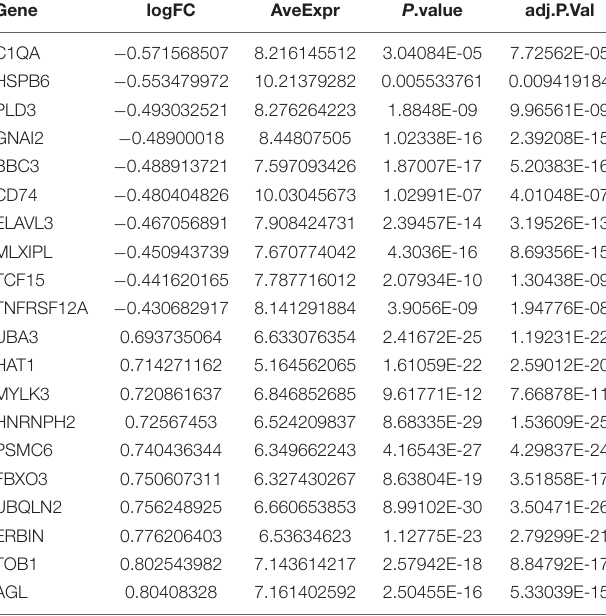
TABLE 2 | Top 10 upregulated and downregulated genes between cluster 1 and cluster 2 are listed. Gene logFC AveExpr P